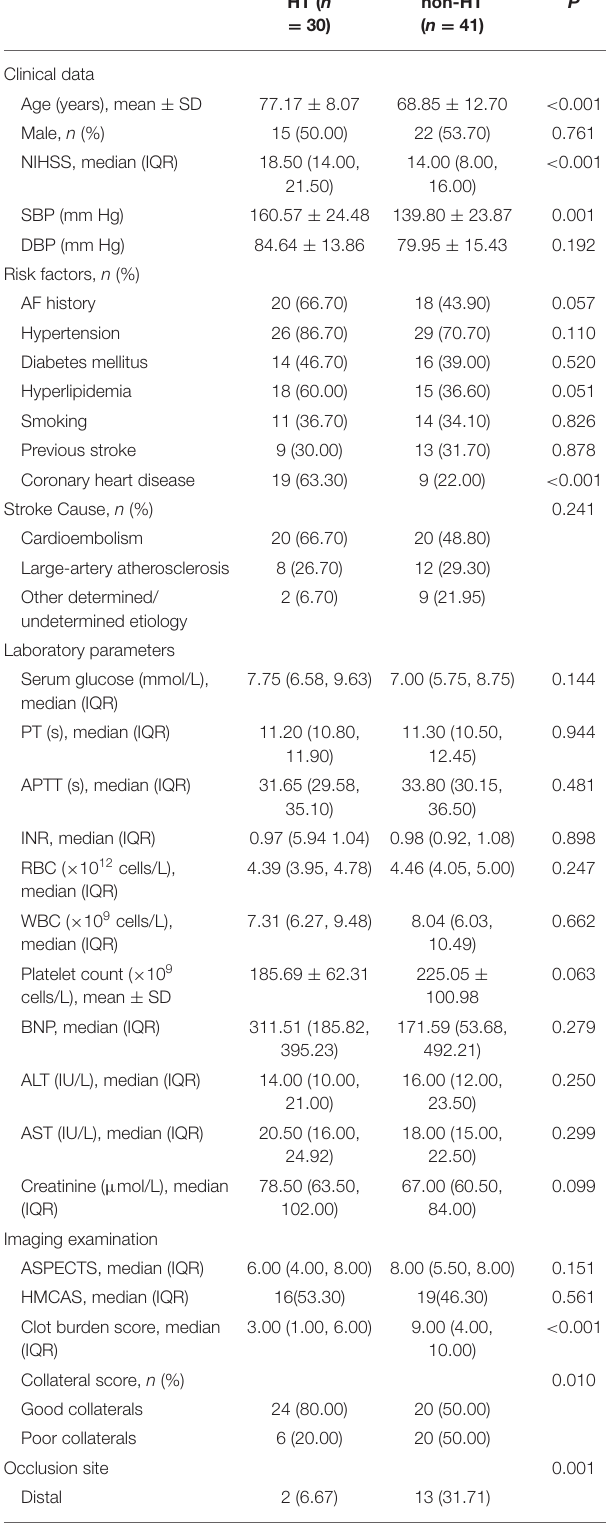
TABLE 1 | Baseline clinical and imaging